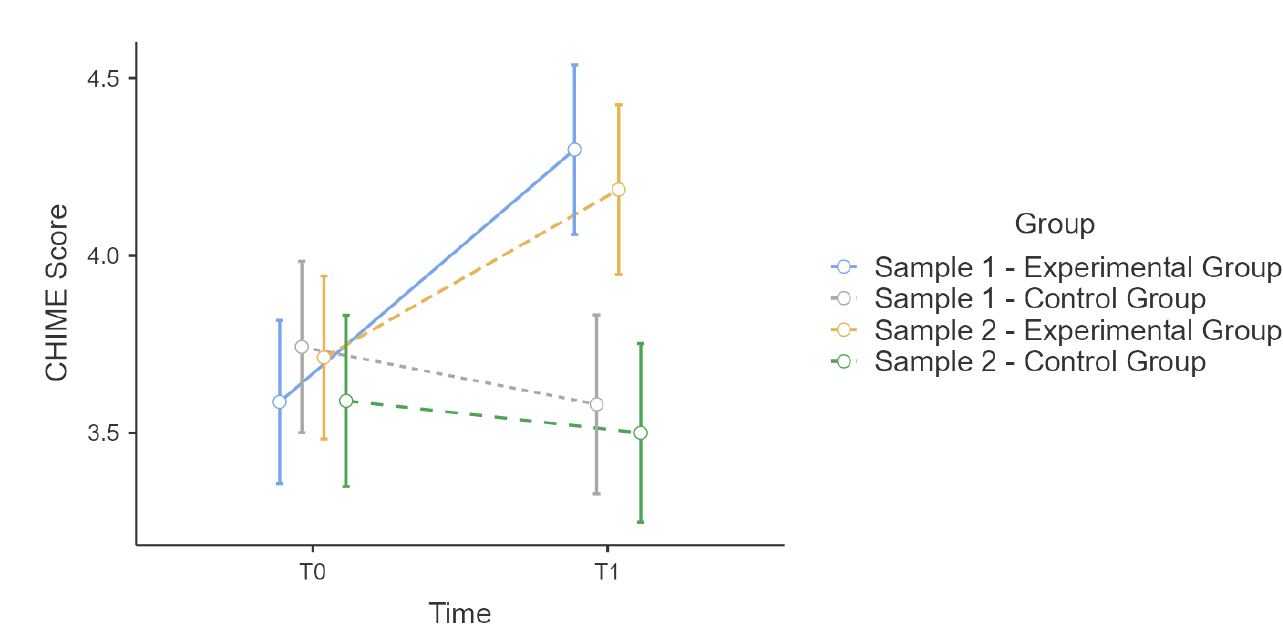
Figure 2. Sample 1 and 2 comparison: Estimated marginal means plot for CHIME score for. Table 3. Repeated Measures ANOVA to test effect equivalence for PSQ and CHIME.